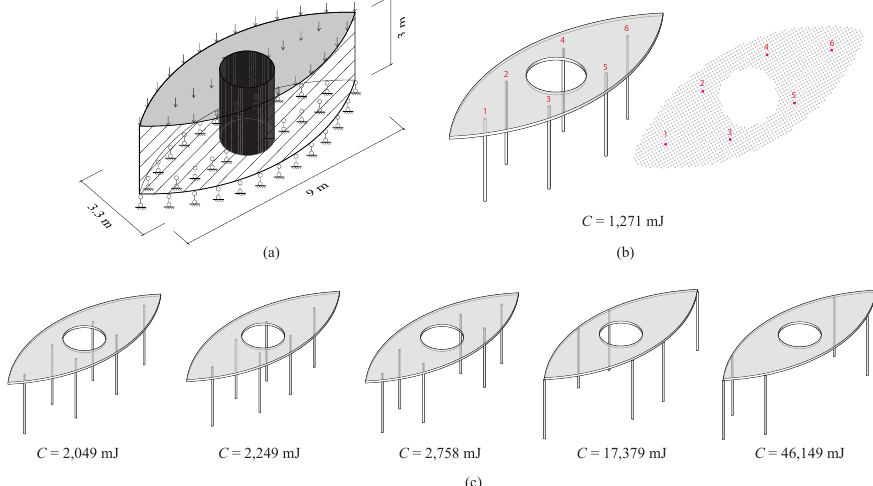
Figure 7. Designing column locations under eye-shaped roof. ( a ) Design domain. ( b ) Optimization result. ( c ) Manual